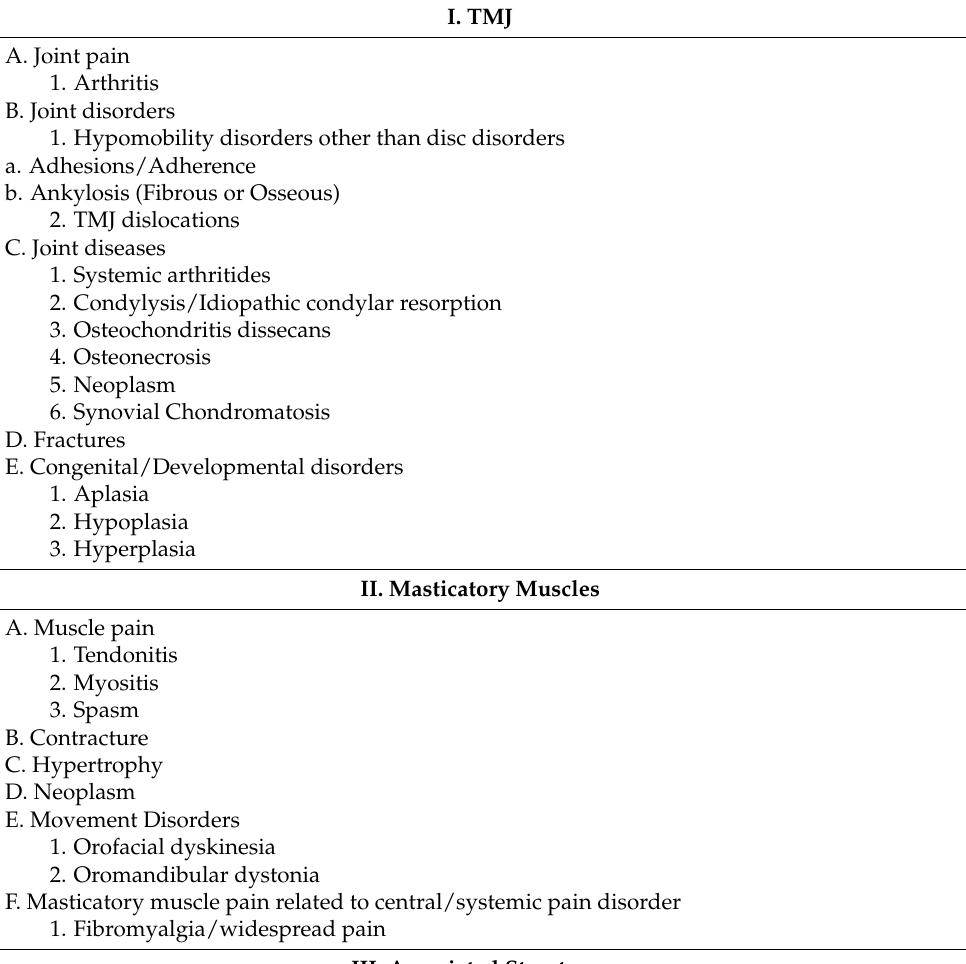
Table 1. Cont. Non-Painful Conditions Clinical Findings Disc displacement with reduction Clicking in the TMJ upon function Disc displacement with reduction with intermittent locking Disc displacement without reduction with limited opening Disc displacement without reduction without limited opening Degenerative joint disease Crepitus of the TMJ upon function Subluxation Modified from Schiffman et al., 2014 [31]. Table 2. Some less common diagnoses of temporomandibular disorders